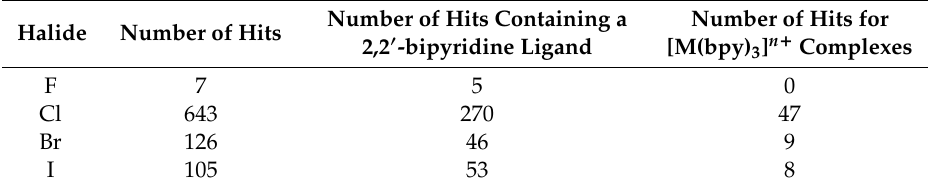
Table 1. Metal oligopyridine complexes containing halide anions found in the Cambridge Structural Database (version 5.41).